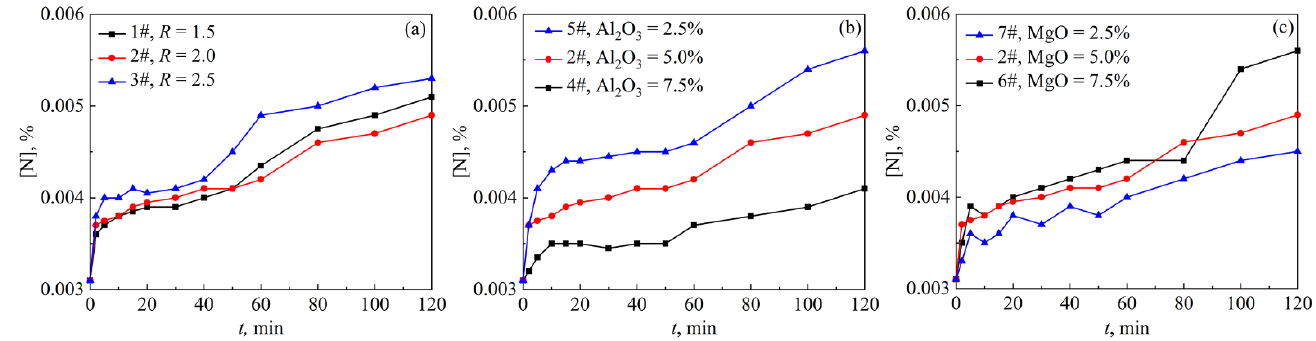
Figure 2. Results of the nitrogen pickup of molten steel in different tests ( a ) different basicity slags; ( b ) different Al 2 O 3 content slags; ( c ) different MgO content slags.